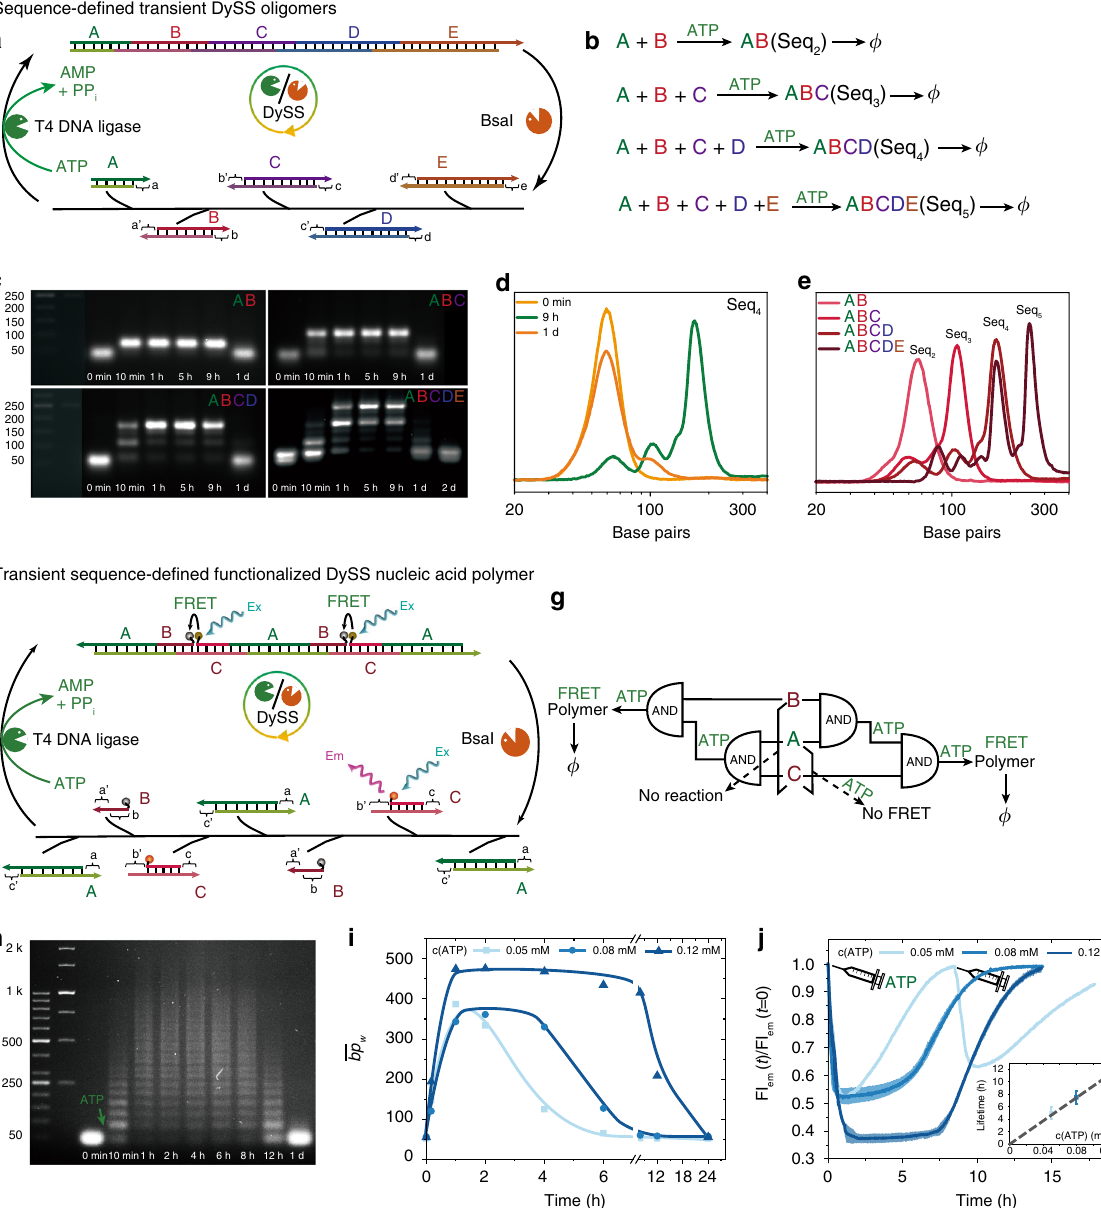
Fig. 3 ATP-fueled transient sequence-de fi ned functionalized nucleic acid oligomers and polymers (SfNAPs). a – e Combinatorial organization of transient and programmable sequence-de fi ned oligomers composed of varying inputs with orthogonally complementary ligation sites. Phi indicates disassembly after ATP consumption. c Time-dependent AGE with d extracted gray scale pro fi les for the transient oligomerization of the tetramer and e the distribution pro fi les of all oligomers in the DySS. f – j ATP-fueled DySS transient SfNAP with transient FRET signaling function. g Logic pathways for the ligation of the inputs to achieve FRET DNA polymers. h Time-dependent AGE (2wt.%, 90V, 2 h) of the transient SfNAP fueled with 0.12mM ATP. i The bp w development with time at different ATP concentrations. Lines are guides to the eye. j Transient FRET signaling at different ATP concentrations ( λ ex = 530nm), and repeated fuel addition for 0.05mM ATP; insert: FRET lifetime control by changing the ATP concentration. Shaded areas and error bars correspond to standard deviations from duplicate measurements. Conditions for a : 0.05mM dsDNA tiles in total; 0.2 mM ATP, 0.92WU μ L − 1 T4 DNA ligase, 1.0U μ L − 1 BsaI,